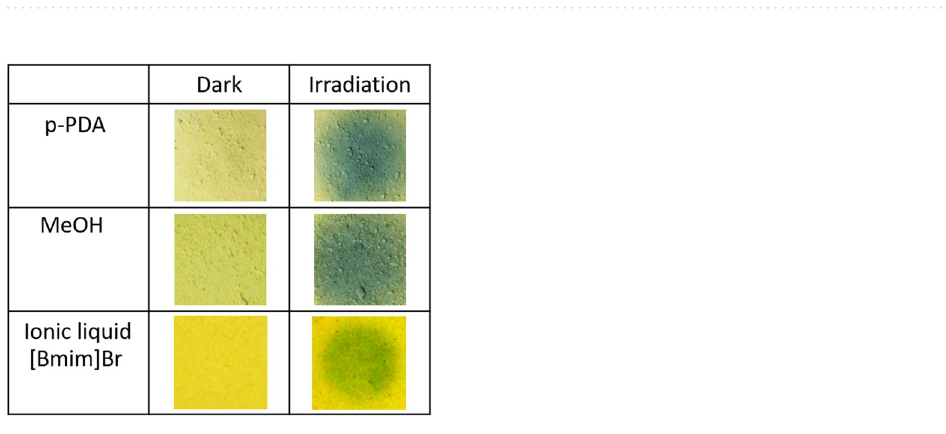
Figure 3. Photographs of PHI before and after white-light irradiation. The sample in the upper panel contains PHI and 0.05 mol/L of p-PDA as an electron donor dissolved in MeOH. The sample in the middle panel is PHI alone immersed in MeOH. The sample in the bottom panel contains PHIG which is composed by PHI and